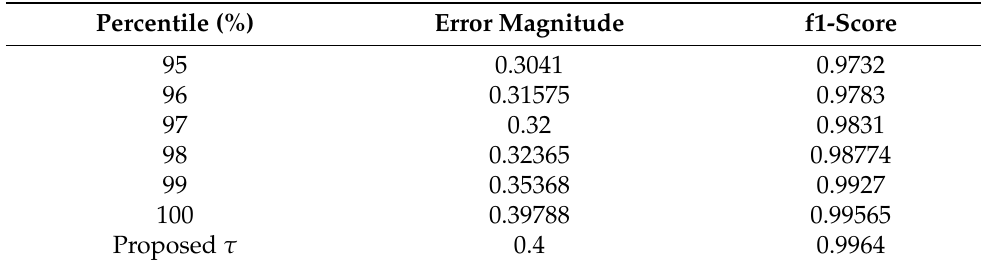
Table 4. f1-score at different threshold